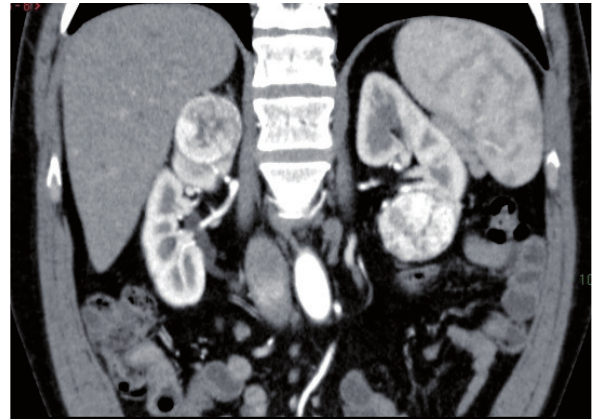
Figure 1 - Patient with bilateral tumors. On the right kid- ney a 6.2 cm upper pole lesion is observed, and a 7cm le- sion is noted in the lower pole of the left